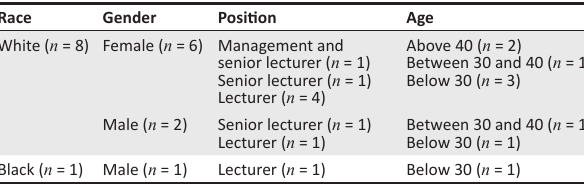
TABLE 1: Biographical information of the sample. Race Gender Position